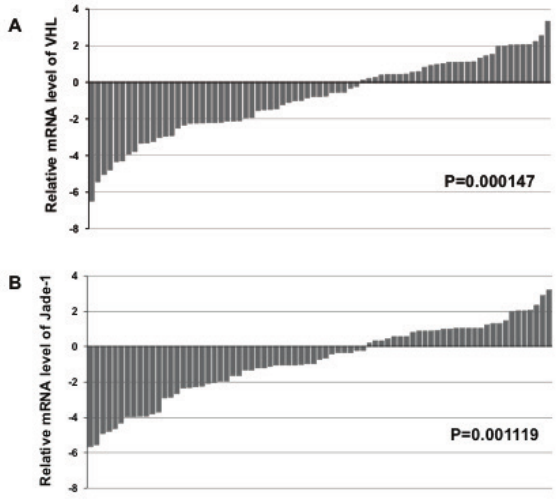
Figure 1: The status and expression levels of VHL and Jade-1 in RCC and adjacent normal tissues. Comparison of relative VHL (A) and Jade-1 (B) expression levels as assessed by real-Time PCR between 75 RCCs and adjacent normal tissues. The relative mRNA expression levels in kidney tumors are presented as fold change = 2 Δ CtN- Δ CtT of tumors versus matched normal